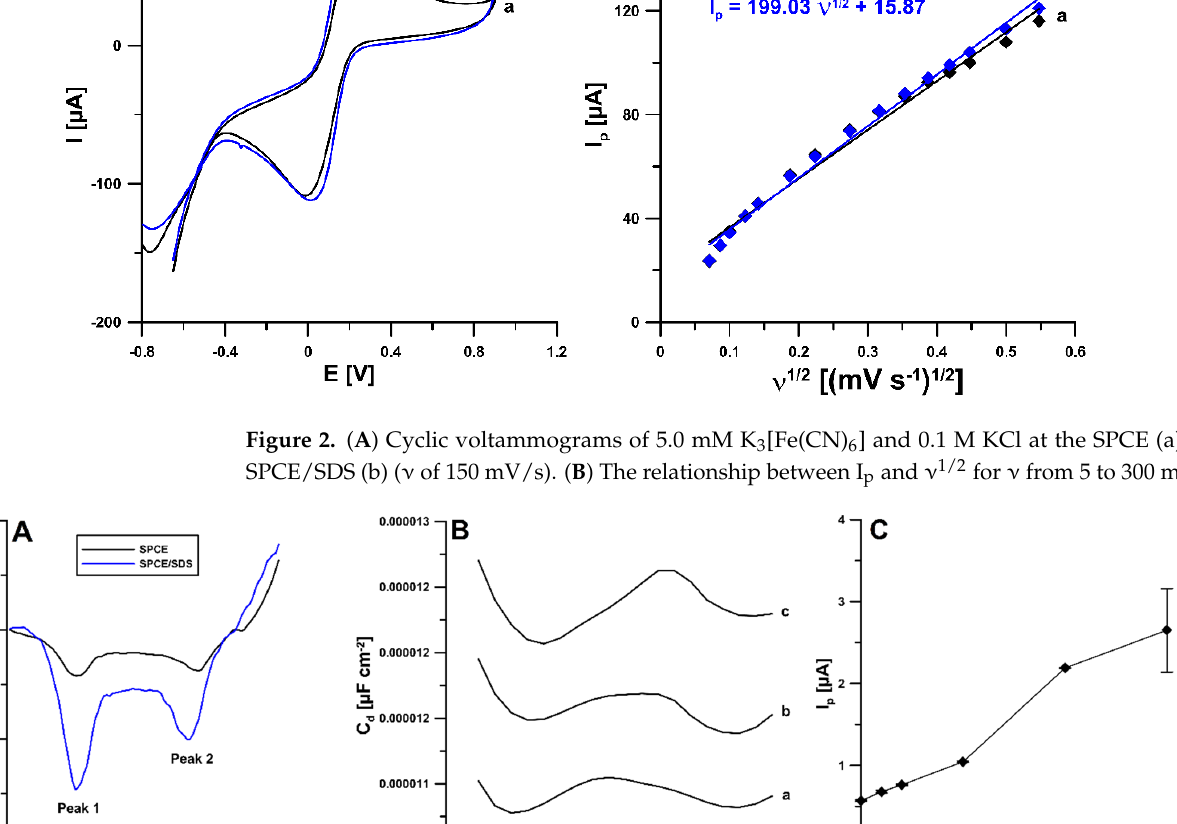
Figure 2. ( A ) Cyclic voltammograms of 5.0 mM K 3 [Fe(CN) 6 ] and 0.1 M KCl at the SPCE (a) and SPCE/SDS (b) ( ν of 150 mV/s). ( B ) The relationship between I p and ν 1/2 for ν from 5 to 300 mV/s.